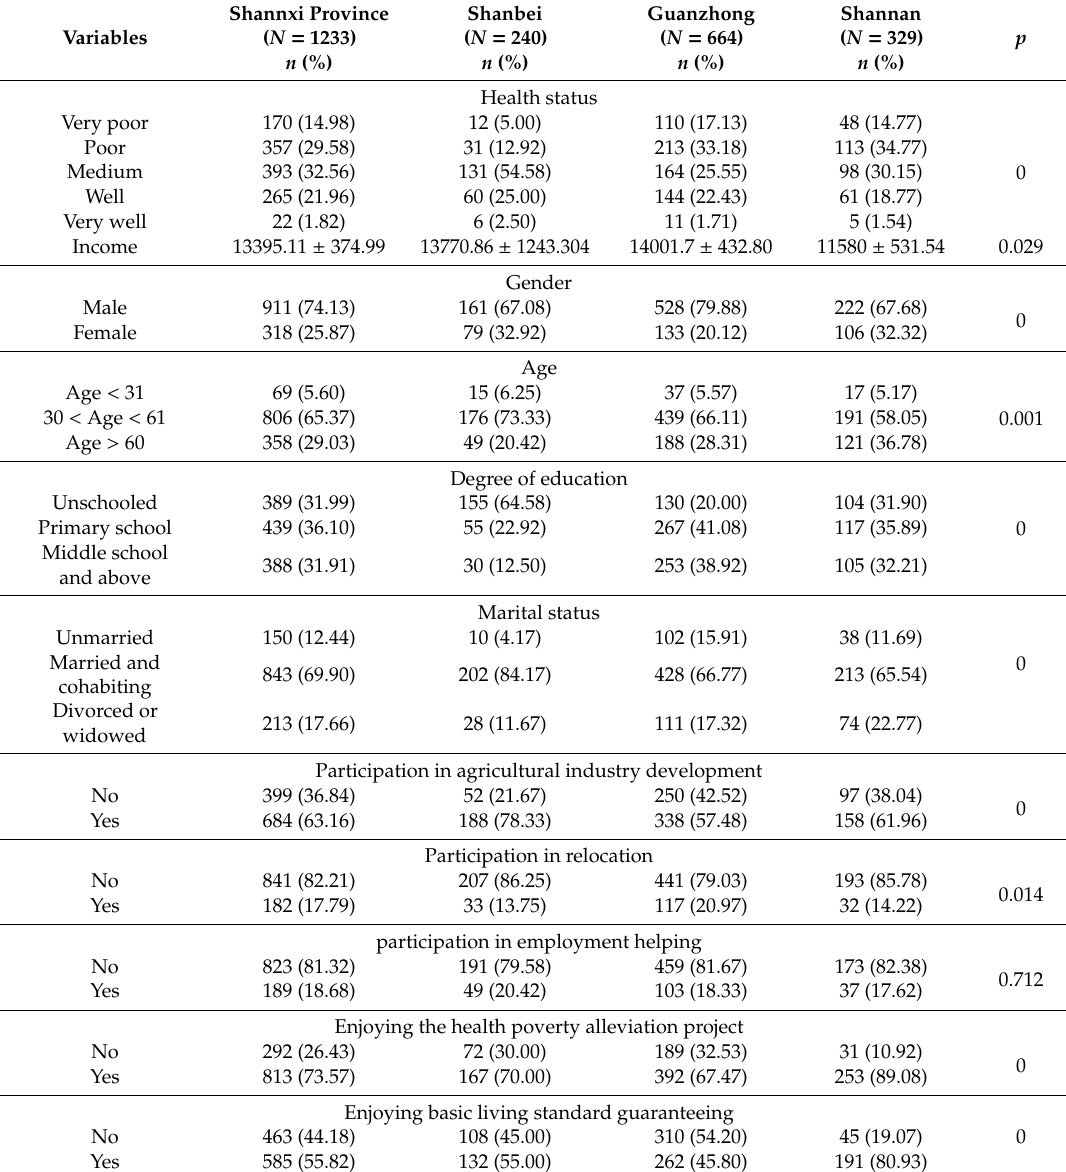
Table 2. Socio-demographic characteristics of rural poor residents and variables